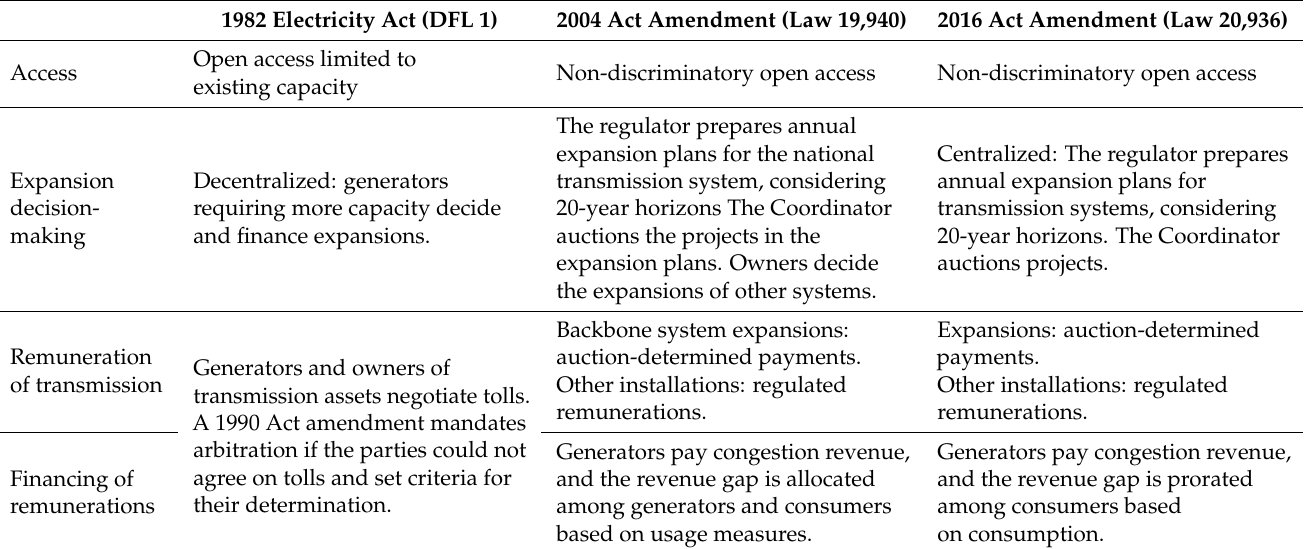
Table 1. Transmission Regulation in